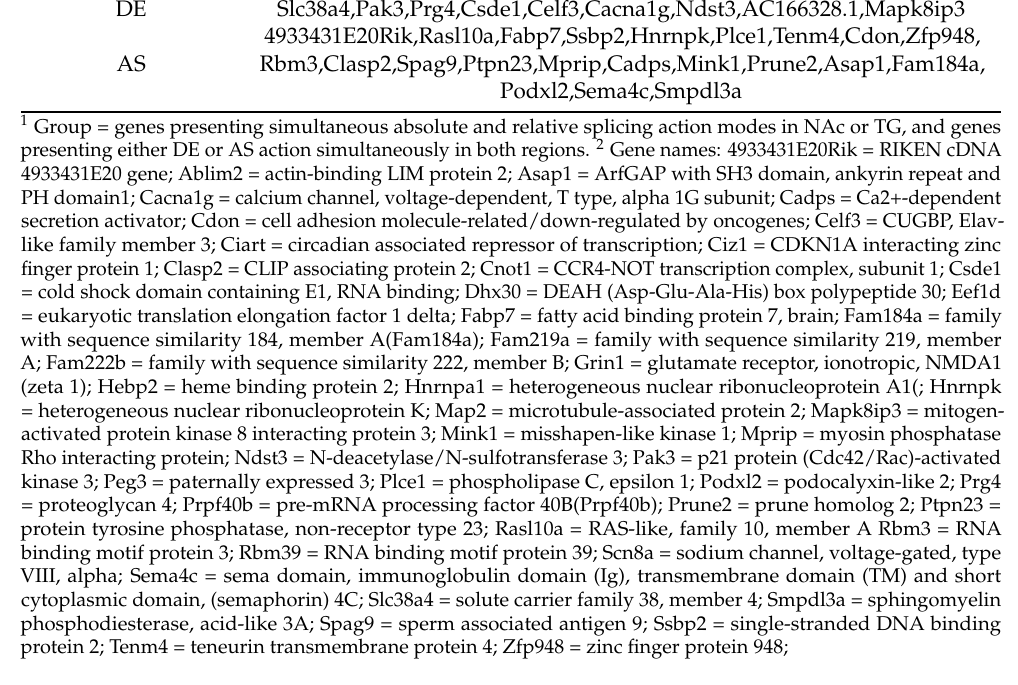
Table 6. Enriched Gene Ontology biological process category among the genes presenting absolute and relative differential isoform expression in the nucleus accumbens and trigeminal ganglia identified using Over-Representation Analysis.